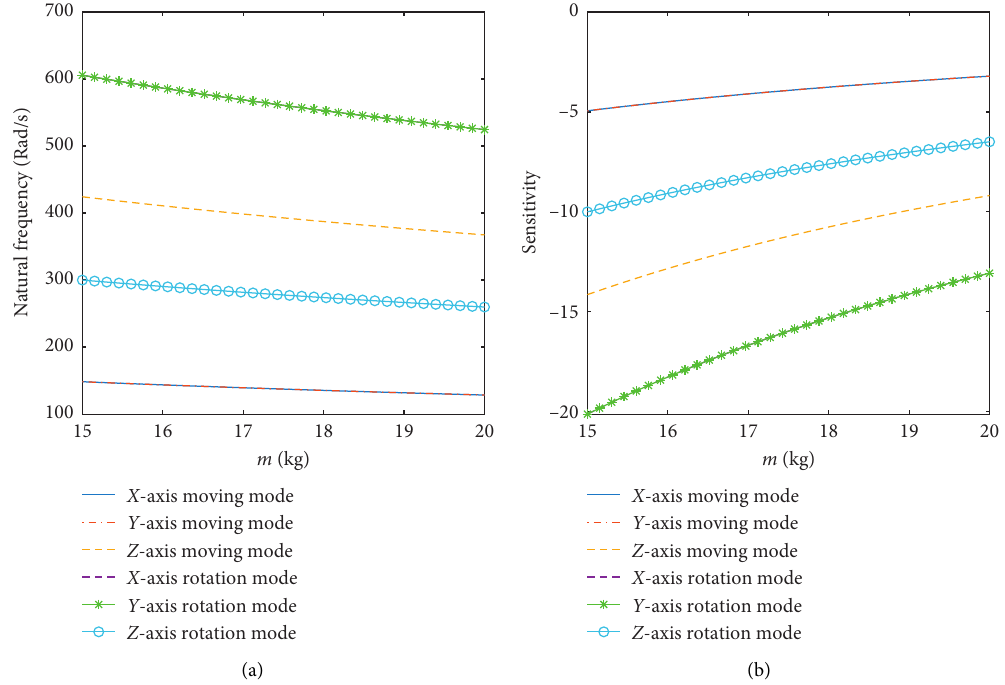
Figure 4: Curves of natural frequency and its sensitivity as a function of upper platform mass. (a) Natural frequency. (b) Sensitivity of natural frequency to upper platform